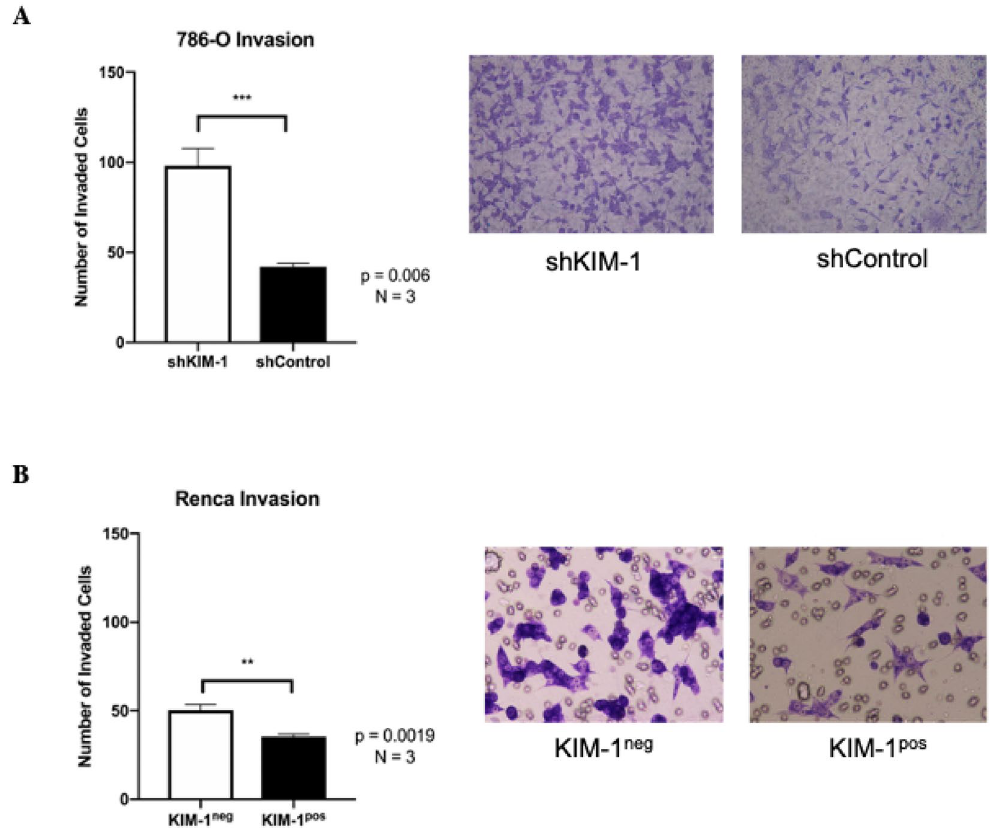
Figure 3. KIM-1 expression inhibits the invasion of human and murine RCC cells in vitro. ( A ) Invasion assay quantification and pictorial representation of the number of invaded 786-O-shControl and 786-O-shKIM-1 cells using Transwell methodology. ( B ) Invasion assay quantification and pictorial representation of the number of invaded KIM-1 pos and KIM-1 neg Renca cells using Transwell methodology. All invasion assays performed with serum free media (SFM) conditions. All membrane images were taken at × 10 magnification and scale bar = 10 µm. All data are represented as mean number of cells ± SD; n = 3 independent experiments ( A ***p = 0.006; B **p = 0.0019), unpaired two-tailed t